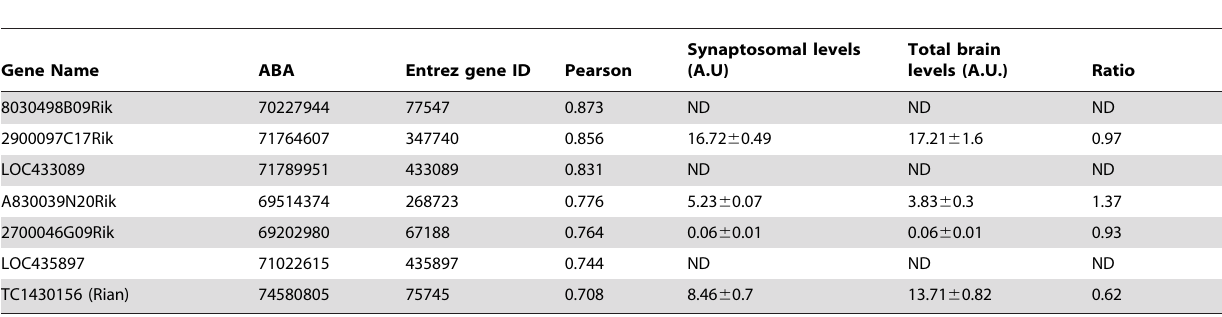
Table 3. Relative expression in adult brain and synaptosomes of the top-scoring non-coding RNAs identified by the Hippo-ATESC pipeline, as determined by qRT-PCR.